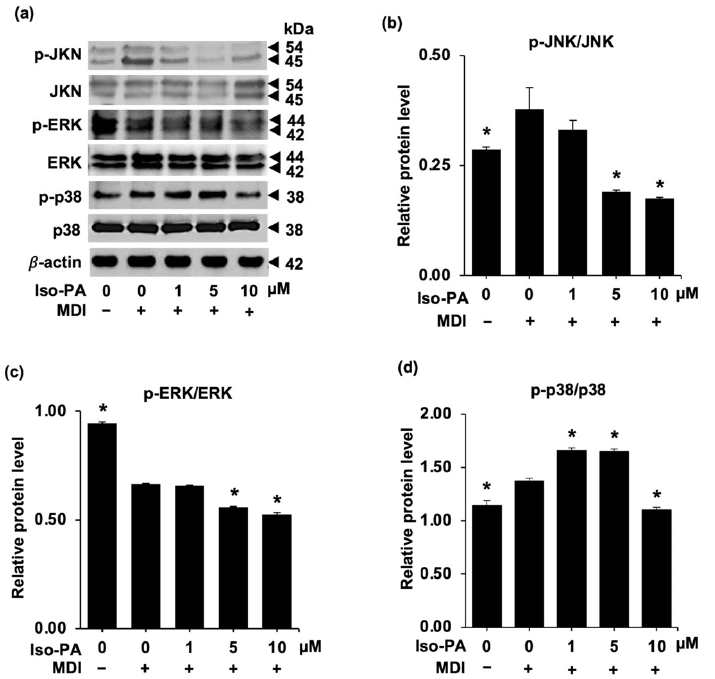
Figure 6. Isopanduratin A deactivates MAPK signaling molecules in differentiated 3T3-L1 cells. ( a ) After 48 h of incubation in differentiation medium containing 1–10 μ M isopanduratin A, cells were subjected to Western blot analysis. The phosphorylation ratios of ( b ) p-JNK/JNK, ( c ) p-ERK/ERK, and ( d ) p-p38/p38 were significantly lower in cells treated with isopanduratin A, compared to the differentiated control groups. Confluent 3T3-L1 cells were cultured in the presence (+) or absence ( − ) of differentiation medium (MDI) with 0–10 μ M isopanduratin A (Iso-PA). Cells treated with 0.5% v / v DMSO functioned as the untreated control (0). Bar graphs demonstrating mean ± SD (n = 3) were created using GraphPad Prism. A one-way ANOVA with Tukey’s post hoc test was used to compare the means of treatment and differentiated control groups (* p < 0.05) .